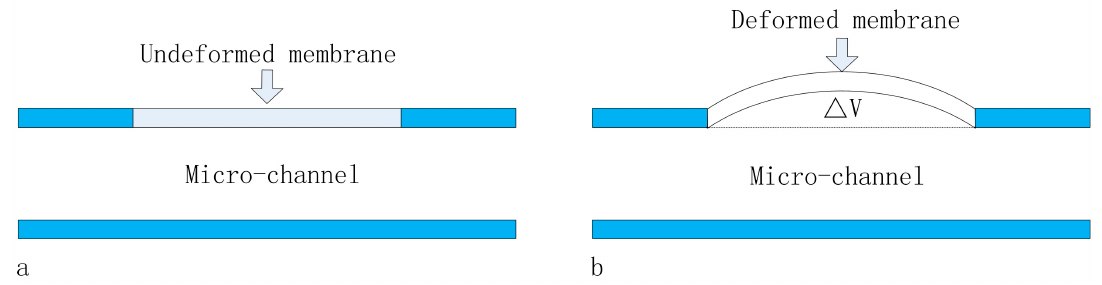
Figure 1. The cross section of a membrane-based microfluidic capacitor: ( a ) an uncharged capacitor and ( b ) a charged capacitor.